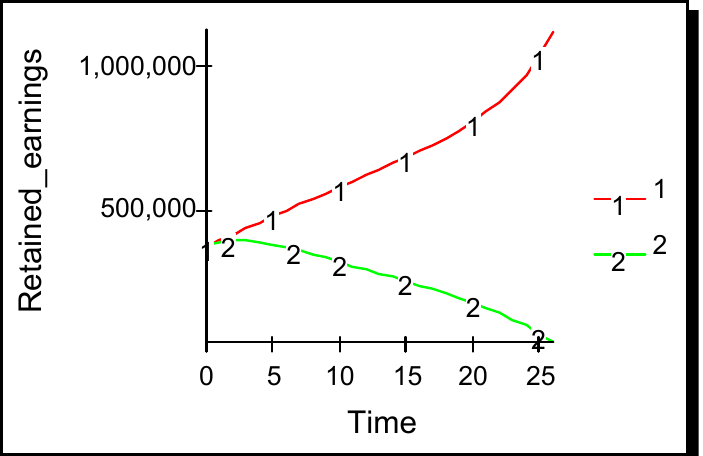
Figure 12. Asymmetric perfectly predatory advertising. Advertising effectiveness: φ 1 = 0.000008; φ 2 = 0.0000075; advertising interaction: ρ = −